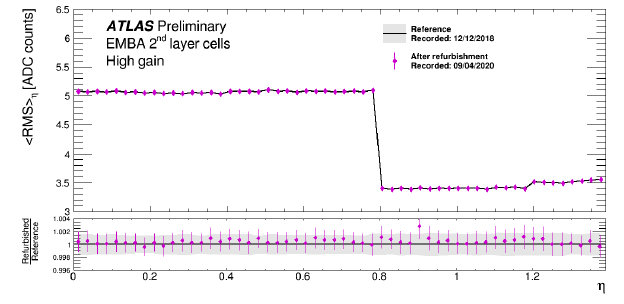
Figure 6: The mean value of the RMS of the pedestal for a given η range measured during a reference run at the end of Run-2 (black line) compared to values measured after the front-end refurbishment (pur- ple dots) during LS2 [10]. The data shown is only taken from the second layer of EMBA. The displayed uncertainties are computed as √ σ rms,cells / N cells , where σ rms,cells is the RMS of the RMS values over the cells in the given η range and N cells is the number of cells in the given η range. The step at η =0.8 can be attributed to a change of the electrode geometrical structure in this region.